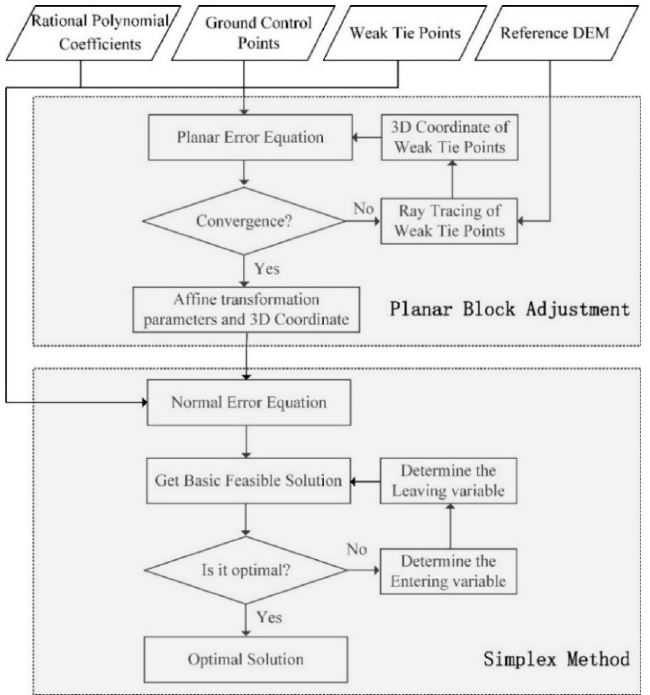
Figure 1. Workflow of image geolocation with weak convergence geometry.